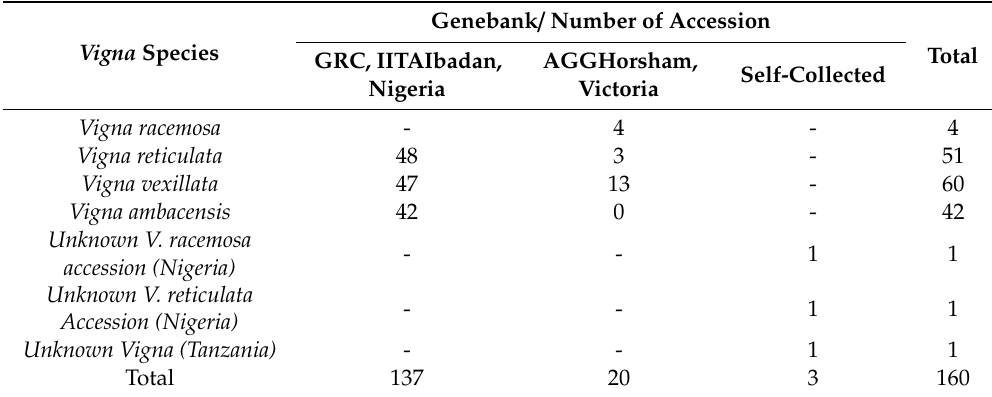
Table 1. Wild Vigna species collected from the gene banks/self.